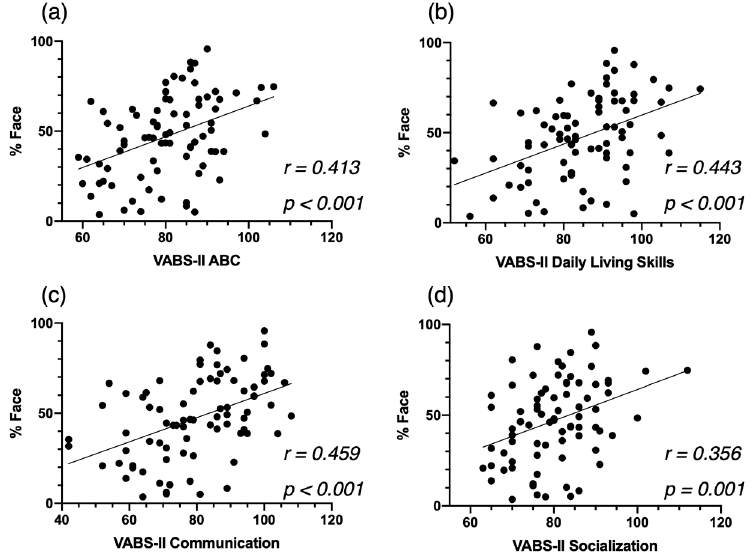
Figure A6. Correlation between %Face and the VABS Adaptive Behavior Composite Score ( a ), the Communication Standardized Score ( b ), and the Socialization Standardized Score ( c ), at baseline for the cross-sectional ASD group, and the Daily Living Skills Standardized Score ( d ).